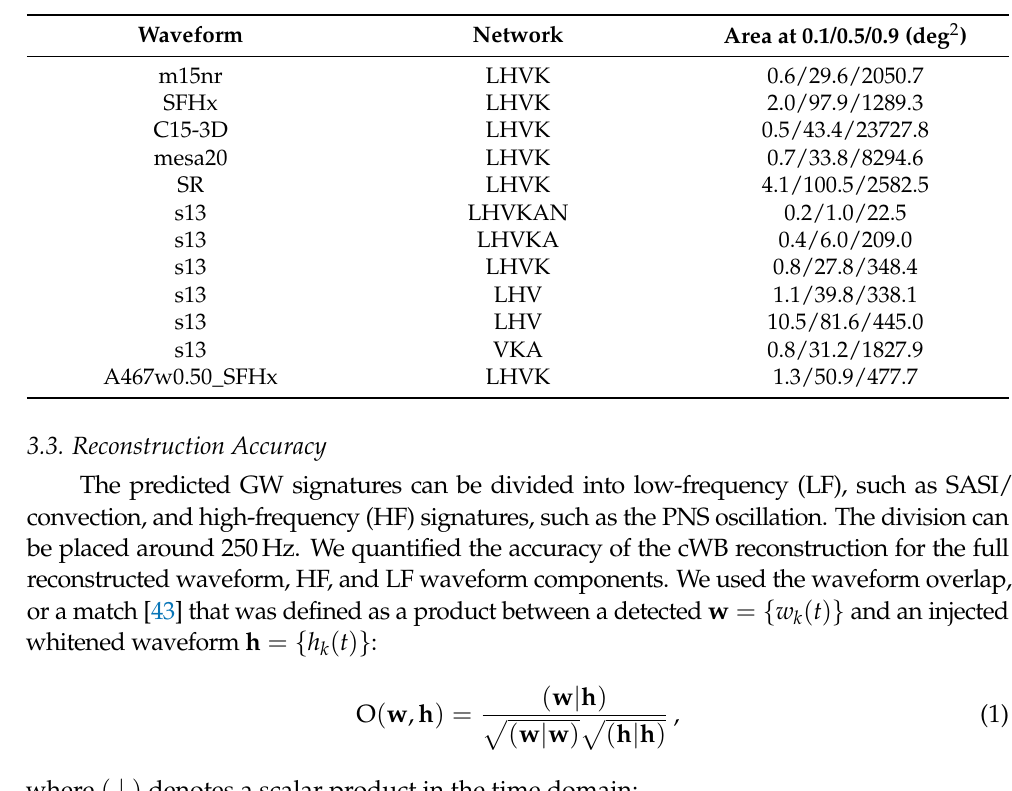
Table 2. Search areas for all waveforms and example detector